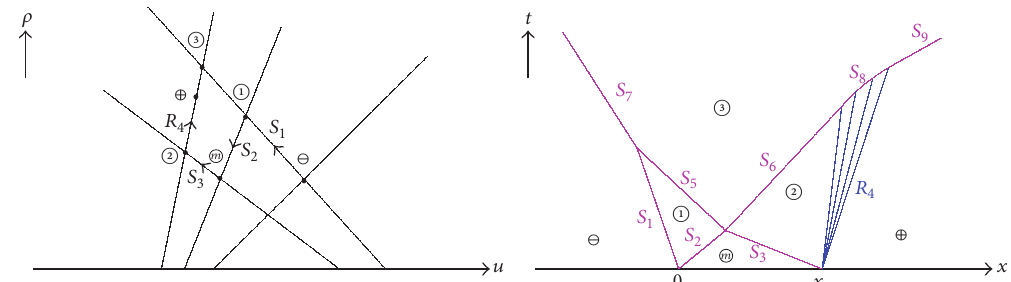
Figure 4: The interaction between 𝑆 + 𝑆 and 𝑆 + 𝑅 is shown when (𝑢 + ,𝜌 + ) ∈ 𝑉 2